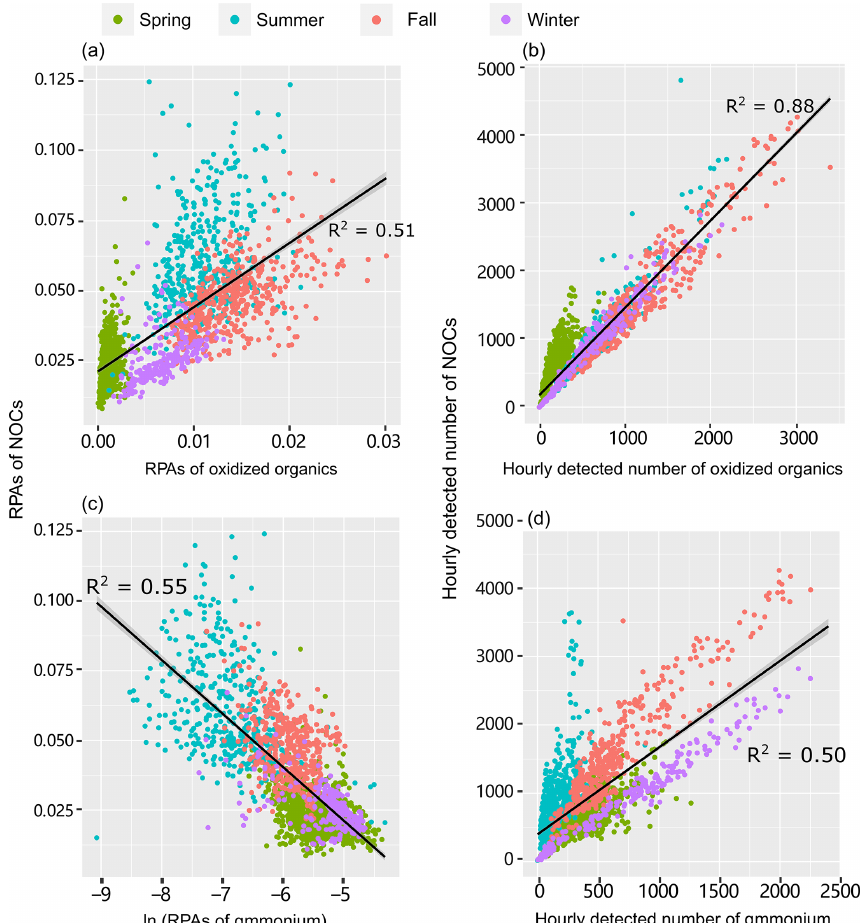
Figure 3. Correlation analysis of (a, c) the RPAs and (b, d) the number of detected NOCs with oxidized organics and ammonium (NH + in different seasons. Significant ( p <0.01) correlations were obtained for both the total observed data and the seasonally separated data. A RPA is defined as the fractional peak area of each m/z relative to the sum of peak areas in the mass spectrum and is applied to represent the relative amount of a species on a particle (Jeong et al., 2011; Healy et al.,